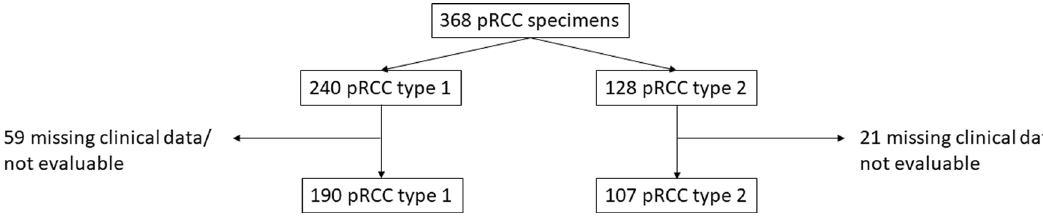
Fig. 1 Consortium diagram of PANZAR